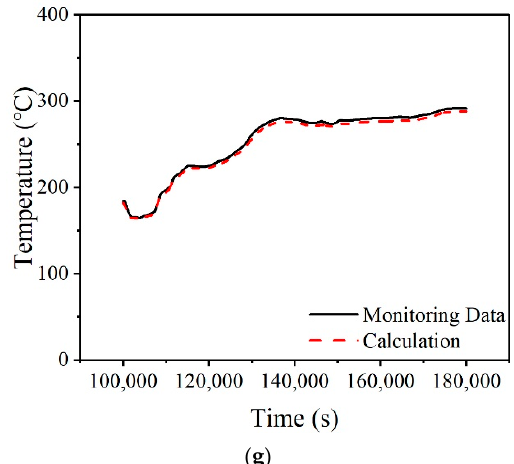
Figure 23. The comparison of calculation result for fixed heat flux and temperature of monitoring points. ( a ) Monitoring Point 31. ( b ) Monitoring Point 32. ( c ) Monitoring Point 33. ( d ) Monitoring Point 34. ( e ) Monitoring Point 35. ( f ) Monitoring Point 36. ( g ) Monitoring Point 37.